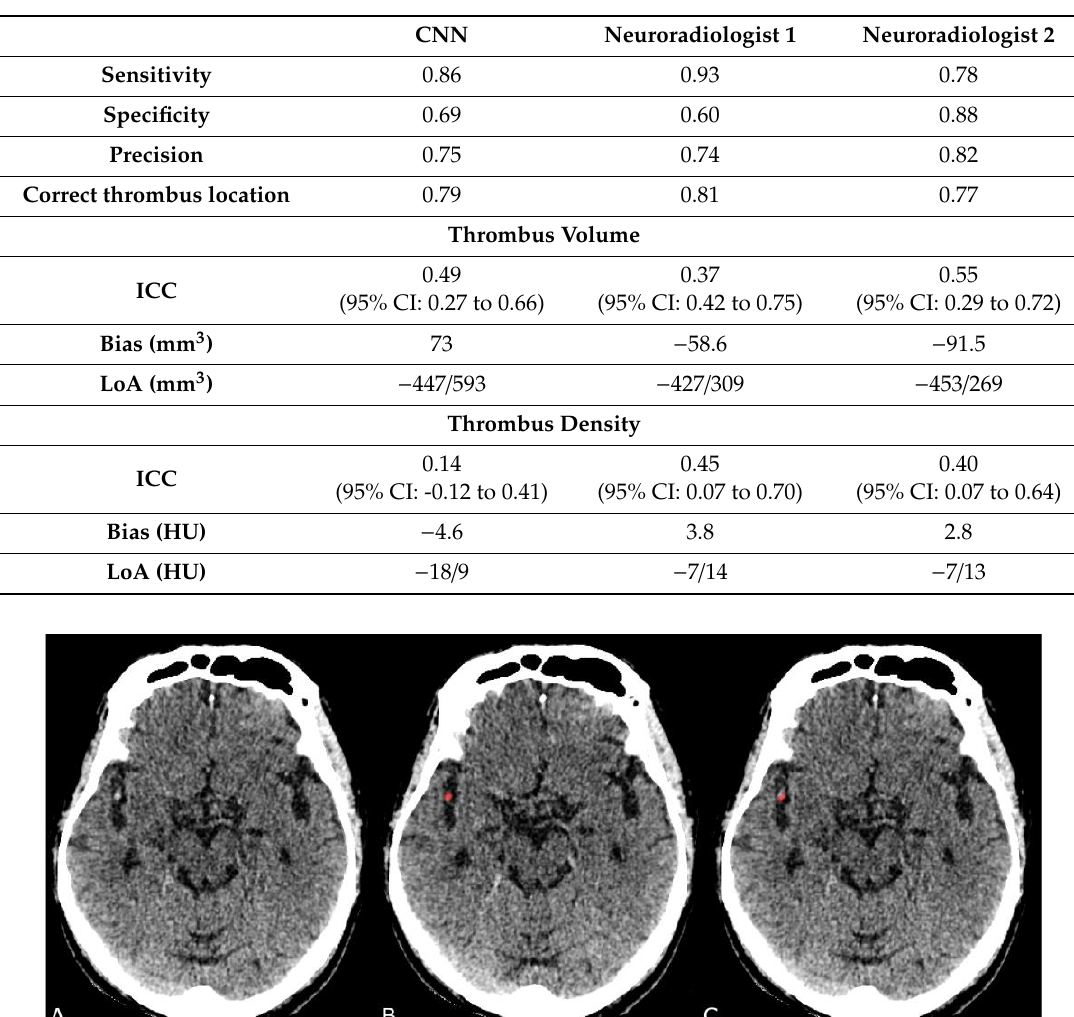
Table 1. Test results from the CNN, neuroradiologist 1 and neuroradiologist 2. The table shows sensitivity, specificity, correct thrombus location assessment rate and the intraclass correlation coe ffi cient (ICC) with bias and limits of agreements (LoA) for both thrombus volume and density.